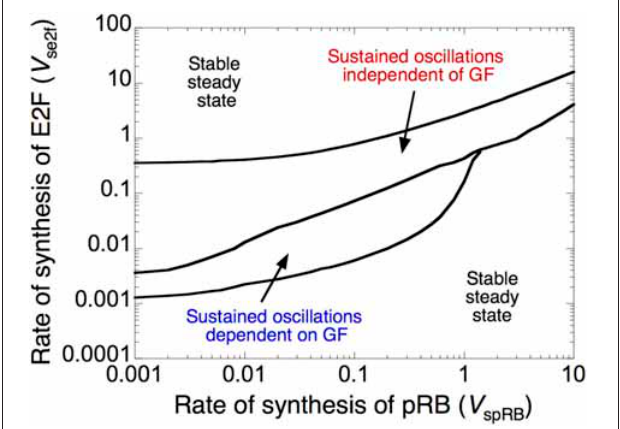
FIGURE 3 | Antagonistic effects of the transcription factor E2F and the tumor suppressor pRB on cell cycle progression. The diagram shows the dynamical behavior of the Cdk network as a function of the rates of synthesis of E2F, v se2f , and pRB, v spRB . Regions in which the Cdk network evolves to a stable steady state, corresponding to cell cycle arrest, surround a domain of sustained oscillations, corresponding to cell proliferation. The domain of sustained oscillations is divided into two parts: in the lower part the oscillations depend on the presence of growth factor, GF (here, GF = 1 μ M), while in the upper part of the domain they become independent of GF ( GF = 0). Parameter values are as in Table S2 in Gérard and Goldbeter